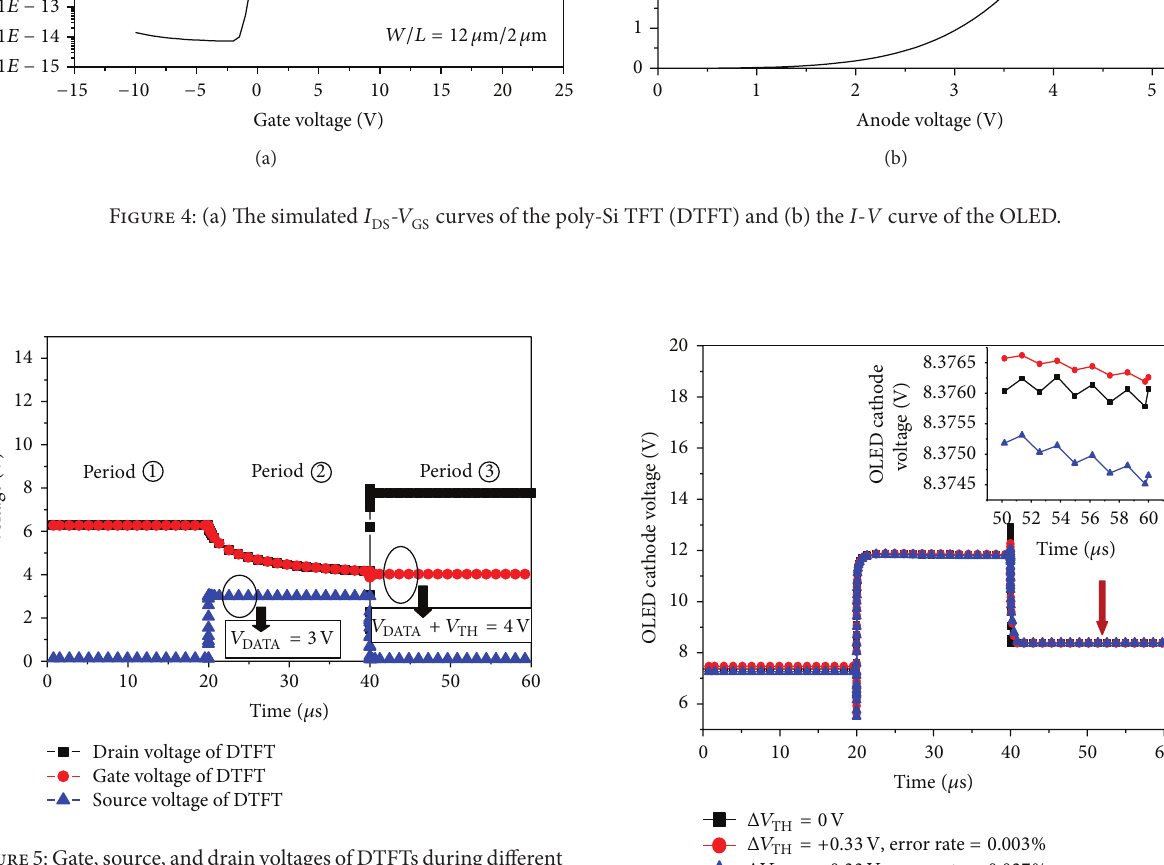
Figure 5: Gate, source, and drain voltages of DTFTs during different operation stages.